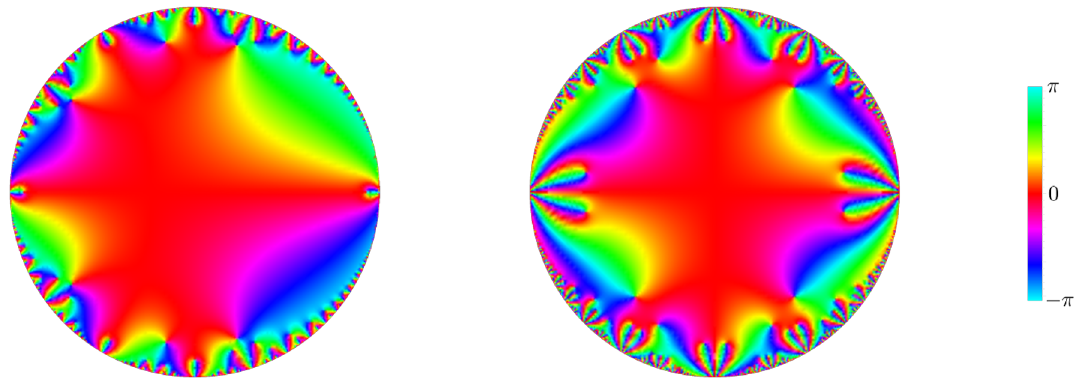
) plotted on the unit- p ) with the p